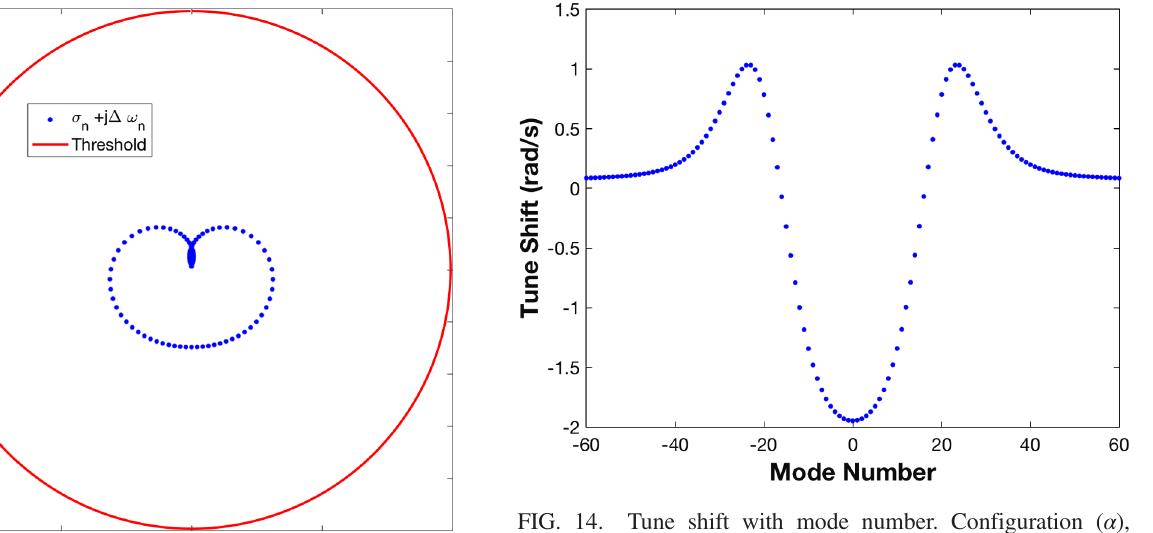
FIG. 14. Tune shift with mode number. Configuration ( α ), OTFB